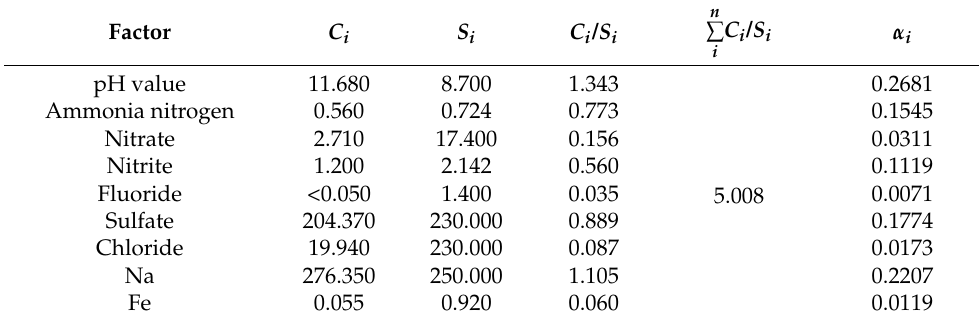
Table 3. Calculation table of weight coefficient of each impact